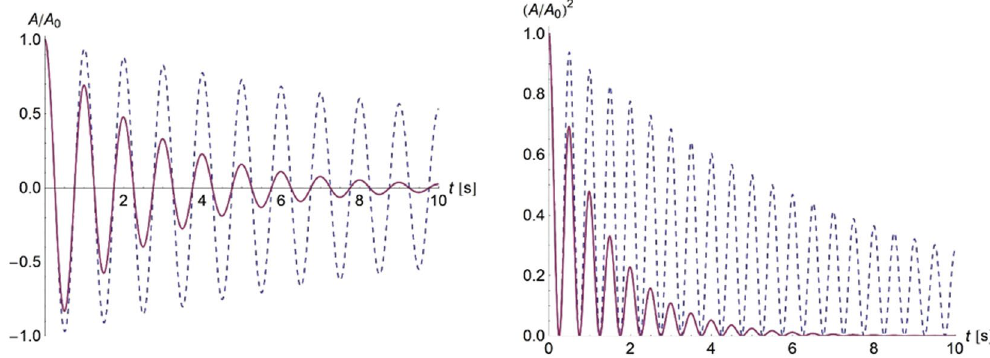
Figure 6. Amplitude decay of the fundamental mode of vibration for simply supported square plates made up of viscoelastic composites with uncoated (dashed lines) and coated (solid lines) beads. The plates have a fundamental frequency of 1 Hz, which is achieved by adjusting their edges L to 1.32 m (coated beads) and 1.25 m (uncoated beads). Shorthand notation A = A 0 ( t ) and A 0 = A 0 (0) is used. The required viscoelastic plane stress-reduced stiffness coefficient Q * is calculated from numerically predicted bulk and shear moduli, K * and G * , respectively 21 , using a standard elasticity relation Q * = 4 G * (3 K * + G * )/(3 K * + 4 G *